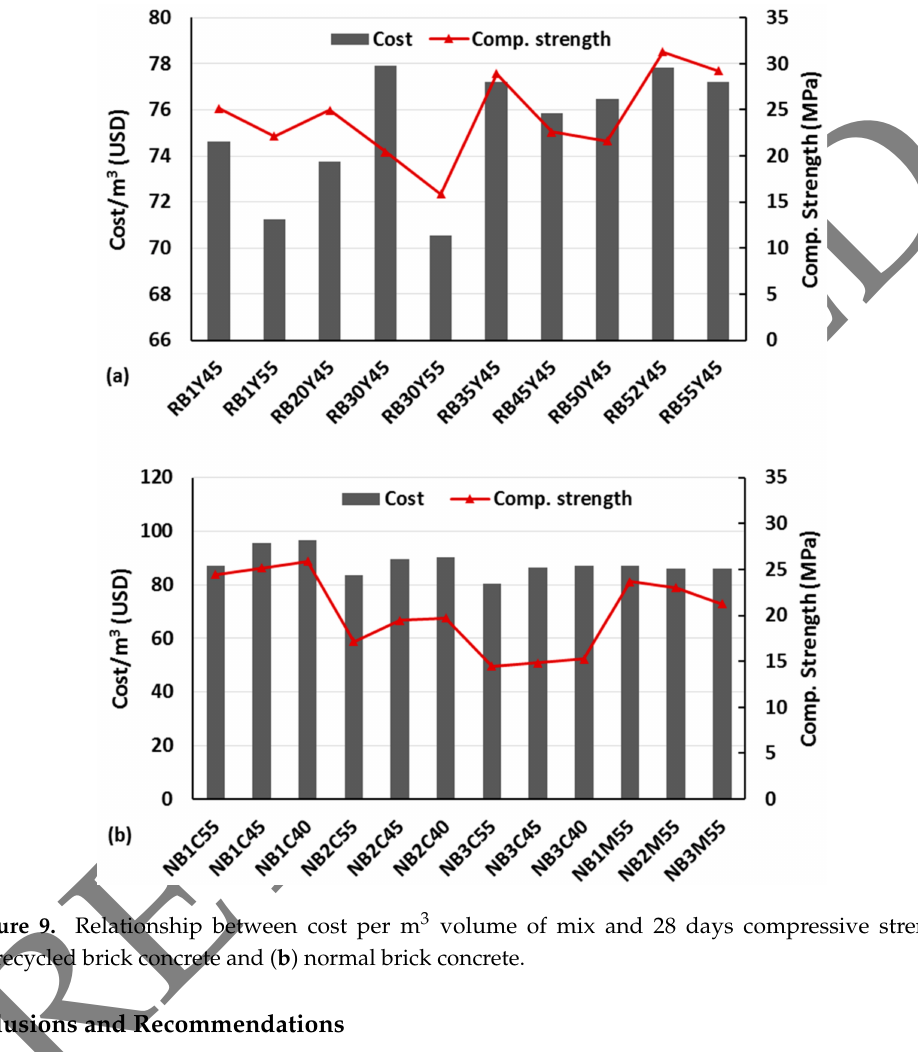
Figure 9. Relationship between cost per m 3 volume of mix and 28 days compressive strength ( a ) recycled brick concrete and ( b ) normal brick